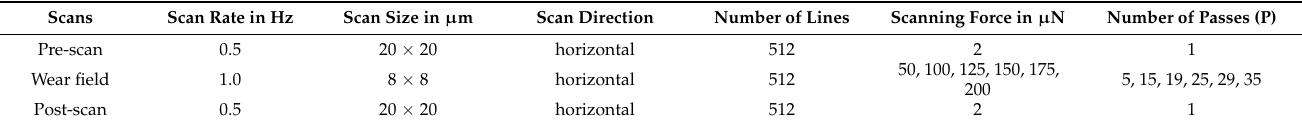
Table 1. Measurement settings for the in-situ SPM for the pre-scan, the post-scan and the wear field.